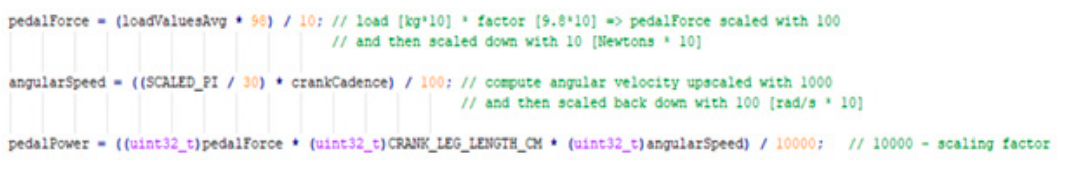
Figure 8. C code implementation of power computing.